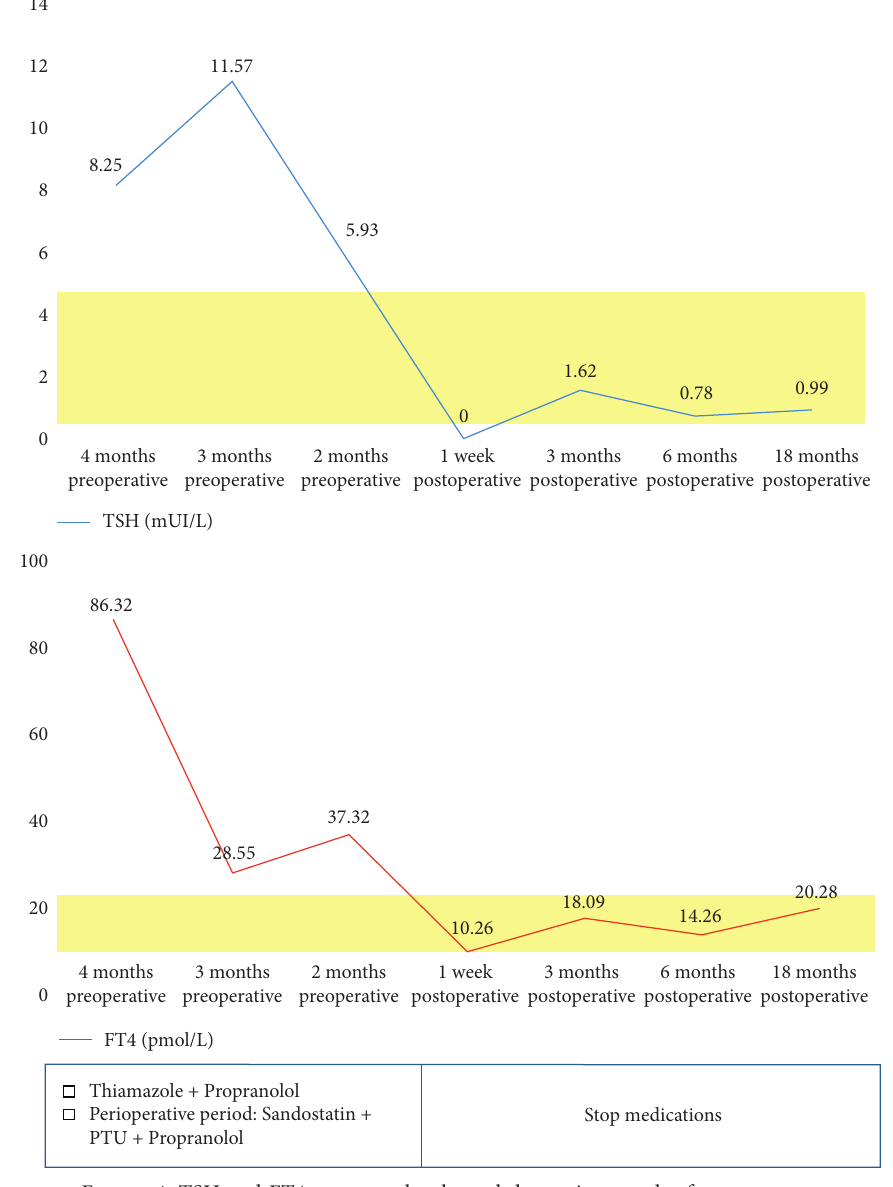
Figure 4: TSH and FT4 assay results showed decreasing trends after treatment. Table 2: Different types of TSH-secreting pituitary adenomas